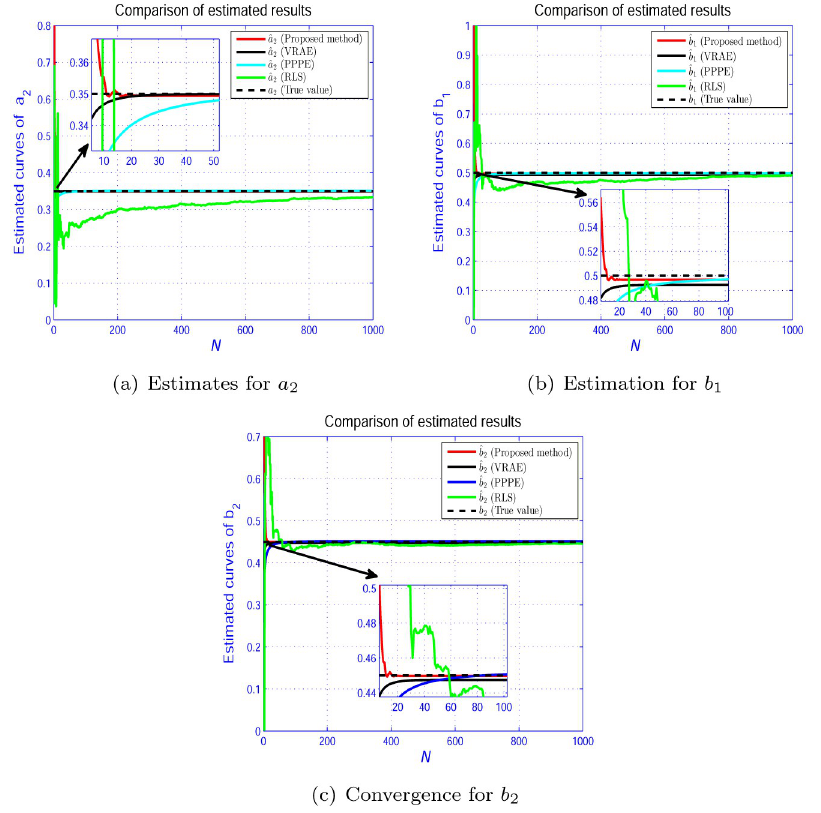
Fig 5. Parameter estimation for L 1 . (a) Estimates for a 2 . (b) Estimation for b 1 . (c) Convergence for b 2 .